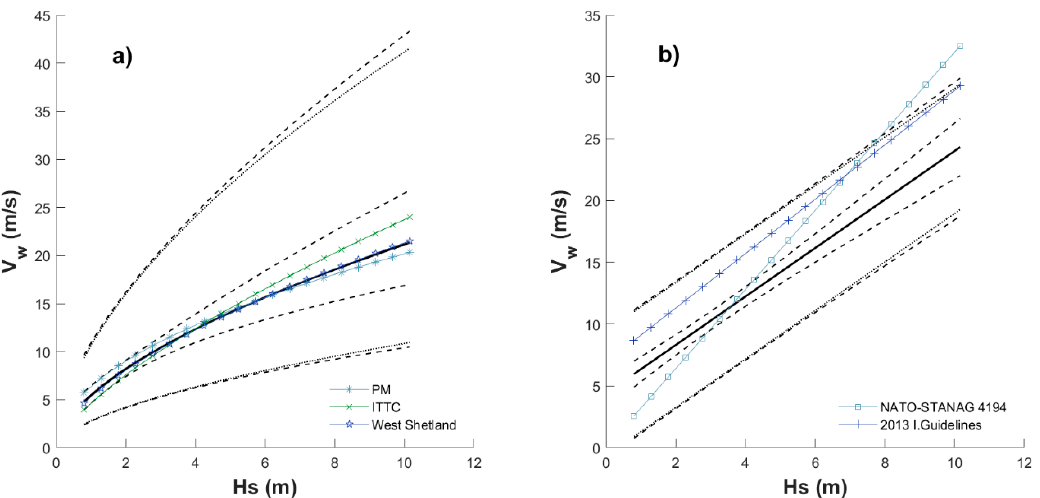
Figure 13. Exact and approximated 95% confidence intervals for August considering the T -yr values: regression ( a ) in logarithmic space and ( b ) in in linear space. Legends indicate expressions referred in [28].